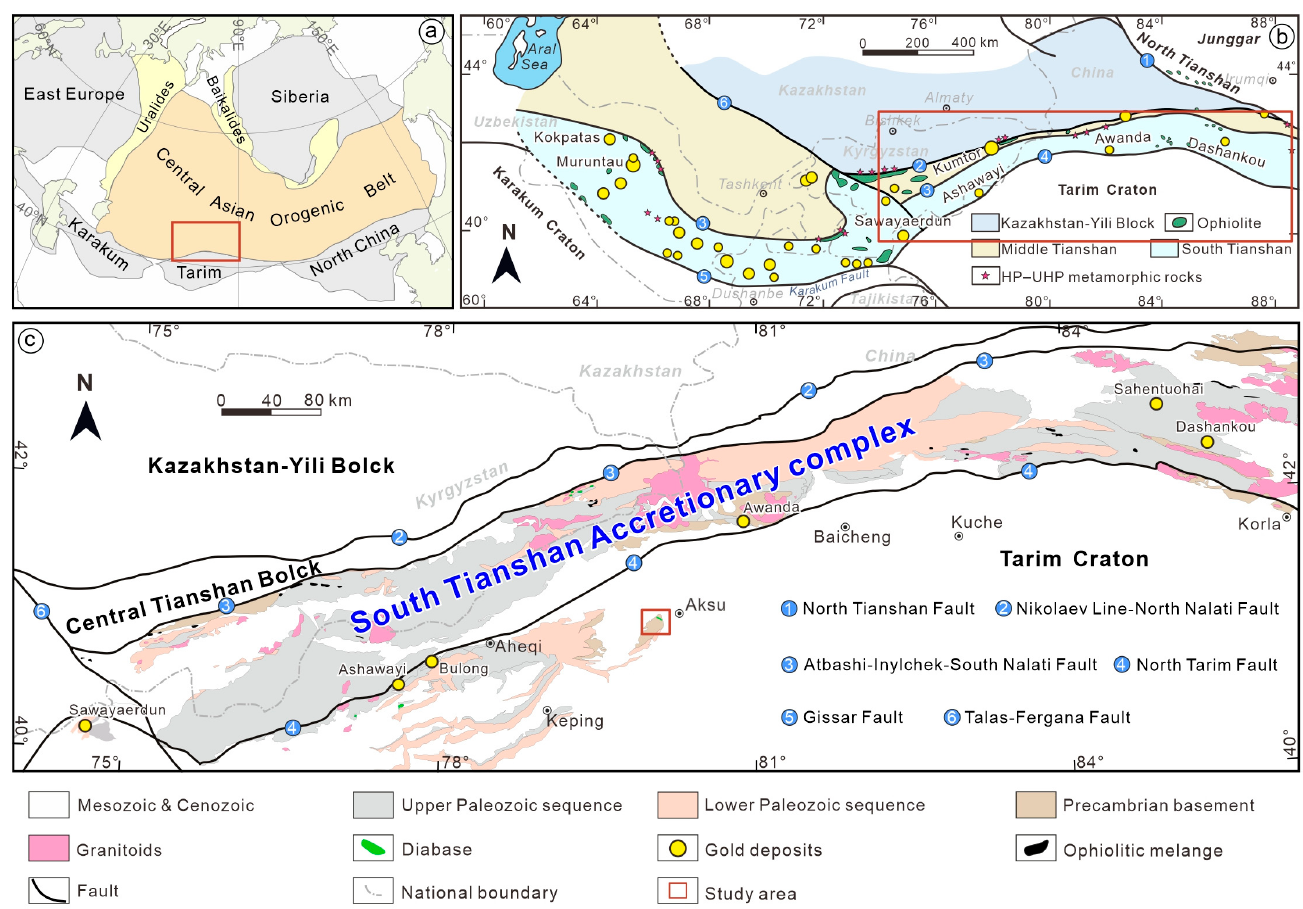
Figure 1. ( a ) Tectonic location of the Tianshan orogen in the Central Asian Orogenic Belt. ( b ) Simplified geological map of Tianshan showing the locations of major lode gold deposits (modified from [16]). ( c ) Geological map of Chinese South Tianshan showing the location of the Aksu terrane (modified from [30]).